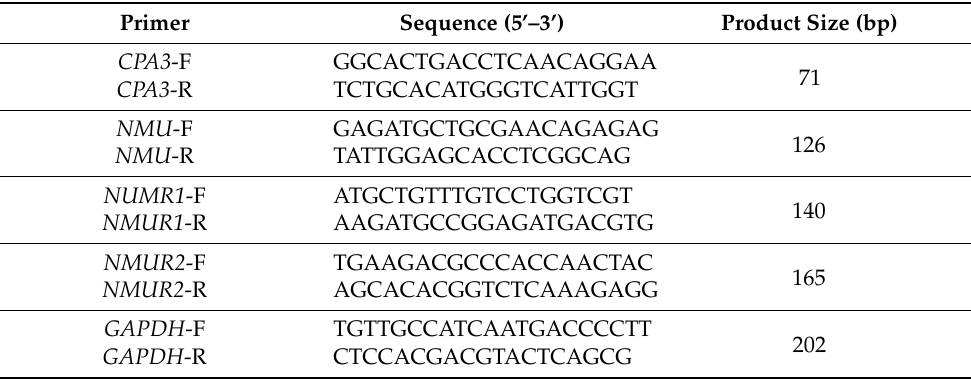
Table 3. Sequences of primers used in this